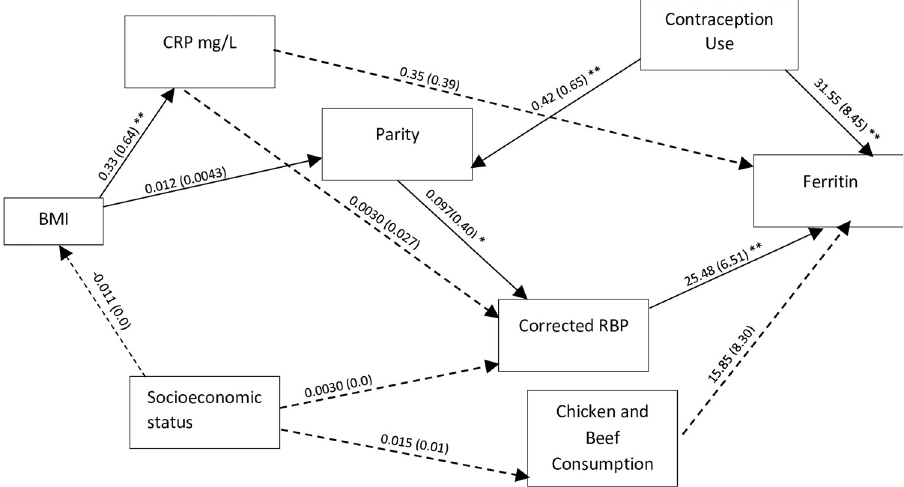
Fig 2. SEM framework for ID outcome. The solid lines represent significant direct effects, and the dashed line is not a significant direct effect. All values are coefficients with standard errors in parenthesis. Significance levels: *** P < 0.001, ** P < 0.01, * P < 0.05. The model statistics were the Root Mean Square Error of Approximation for: 0.026, the Comparative Fit Index: 0.958, the Tucker-Lewis Index: 0.921 and SRMR: 0.035.